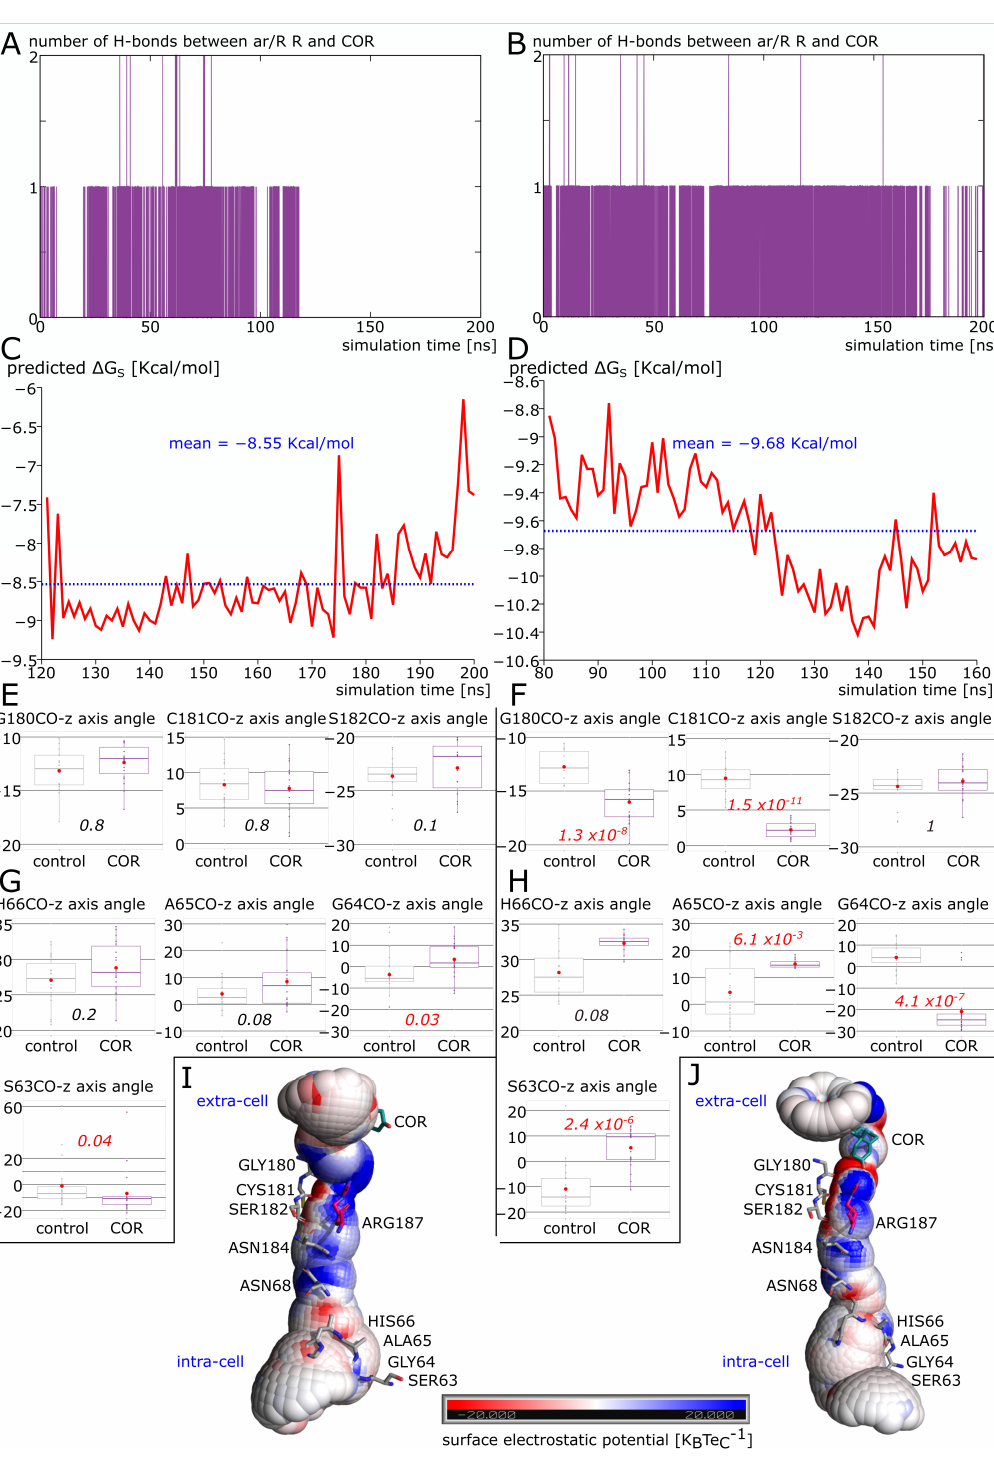
Figure 6. Impact of cortisol interaction with ar/R arginine upon AQP2 pore structure and electrostatic potential profile. In this figure, data corresponding to chain B are always displayed on the left while data corresponding to chain D are on the right. ( A , B ) Number of hydrogen bonds between cortisol and ar/R constriction arginine 187 as a function of simulation time for chain B and D, respectively. ( C , D ) . Binding free energy of cortisol with extra-cellular vestibule of chain B and D, respectively. ( E – H ) Comparison between conditions “control” and “COR” of the angle formed between C–O axis of pore lining residues and the z axis. Positive values indicate oxygen atoms orientated toward the extra-cellular extremity of AQP2 and negative values correspond to the opposite. E and F